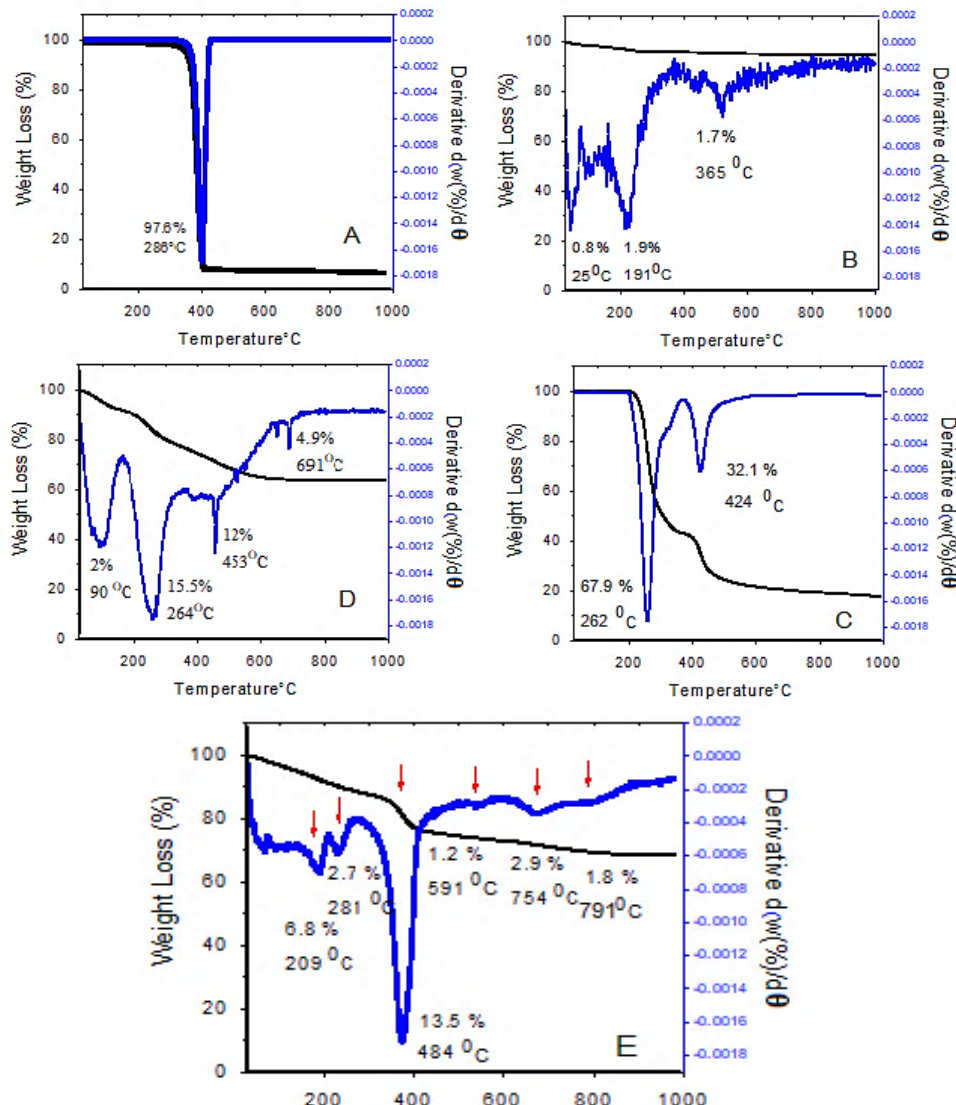
Figure 5. Thermogravimetric/differential thermogravimetric analyses (TGA/DTG) thermograms of ( A ) pure PEG; ( B ) superparamagnetic iron oxide nanoparticles; ( C ) pure sorafenib; ( D ) pure Zn/Al LDH; and ( E ) drug-loaded magnetic nanoparticles (M-PEG–SO–ZLDH).